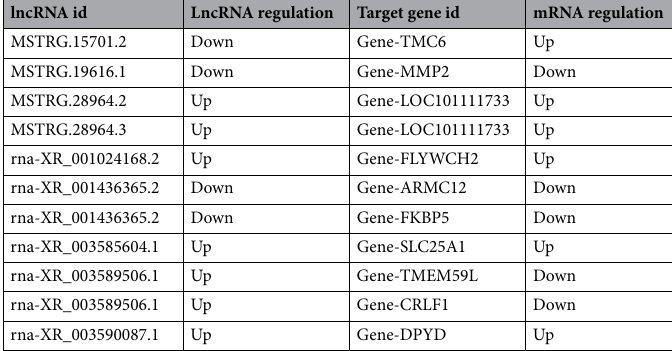
Table 2. Prediction of differentially expressed lncRNA target genes.